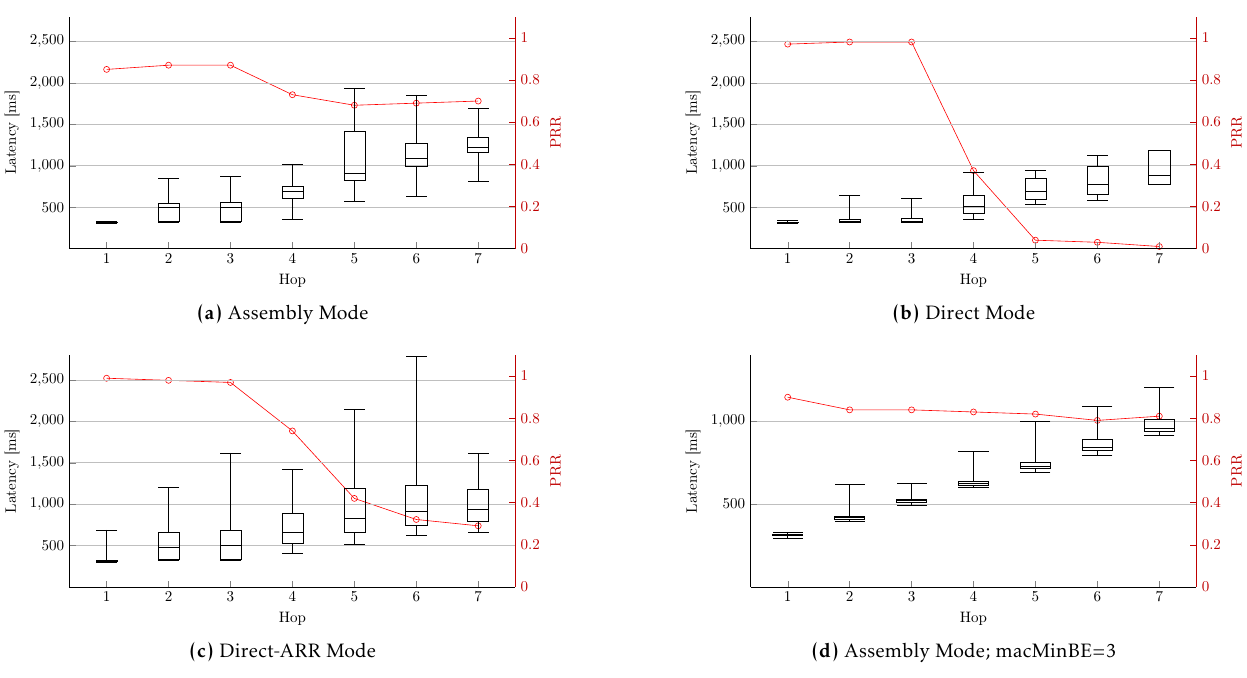
Figure 11. Per hop latency and PRR in the testbed with 37 . 5 B/s and 1200 Byte payload; second set of experiments, except 11d, which is a result for macMinBE=3 and is shown for reference (note the different scale on the left y-axis) for losses for the direct modes in the RealSim and testbed